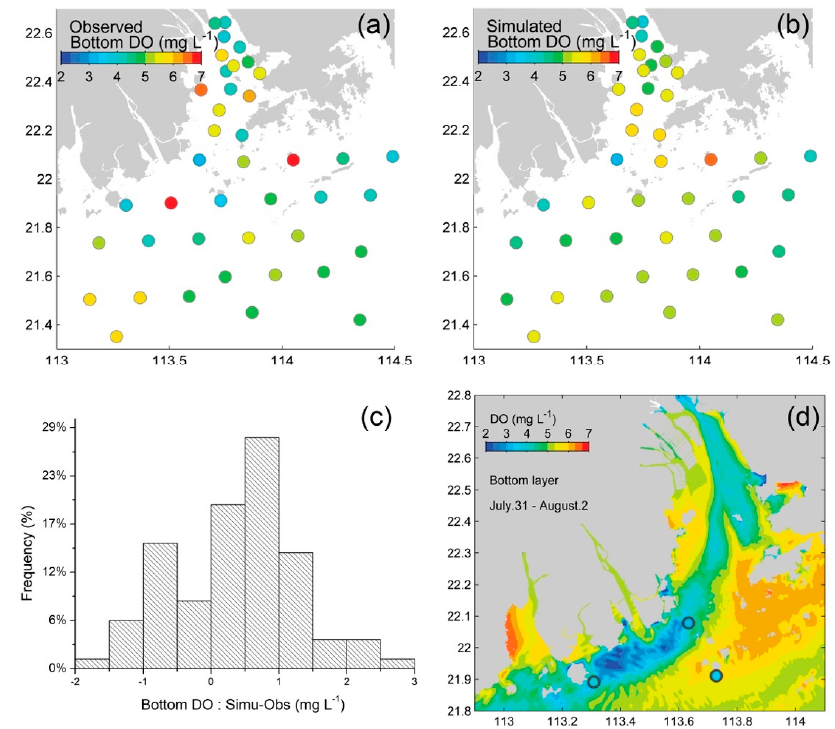
Figure 6. Comparisons of the ( a ) observed and ( b ) simulated bottom DO concentration. ( c ) Histogram of the simulated DO minus observed DO. ( d ) Simulated averaged bottom DO distribution from 31 July to 2 August 2006; simultaneous observations are superimposed in dots.